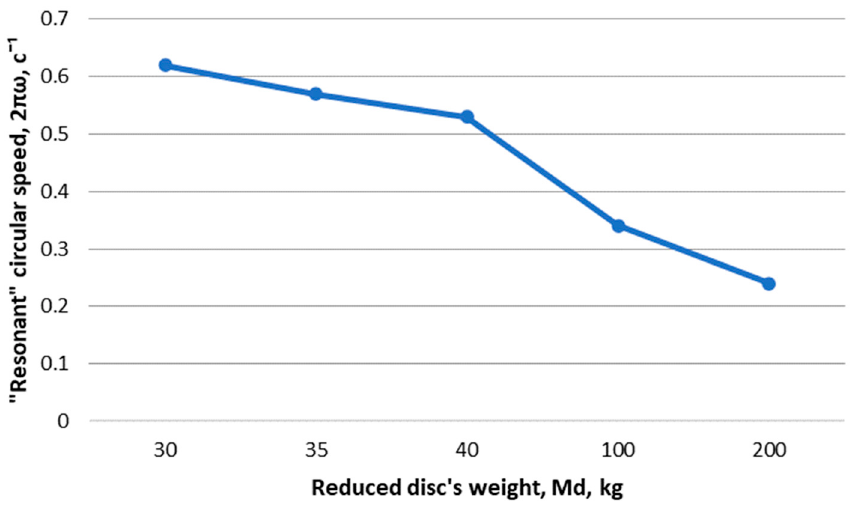
Figure 5. Effect of the upper reduced disc’s weight on the circular speed in well no. 3633.